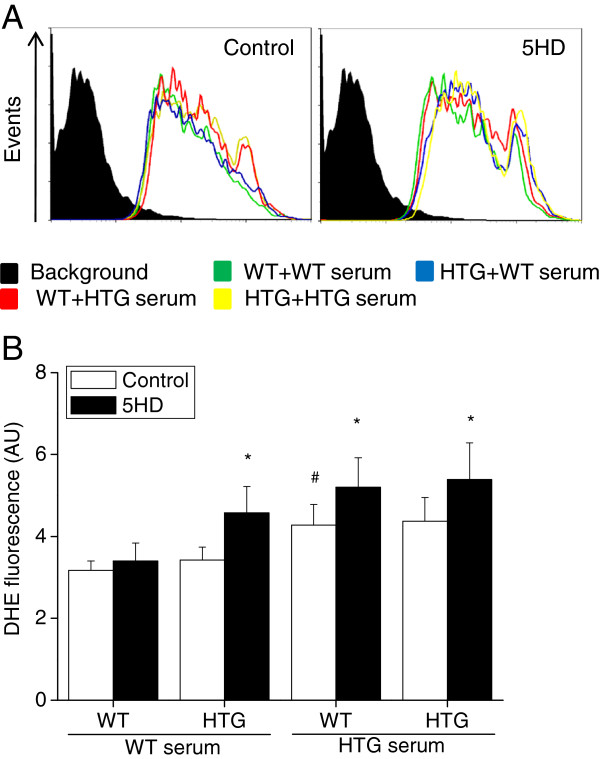
Blood serum from HTG mice induces superoxide generation in spleen mononuclear cells. Representative plots from flow cytometry analyses are shown in A, and means ± SEM are depicted in B. Cells (106 cells.ml-1) were incubated for 4 h in RPMI 1640 medium containing 10% serum obtained from WT (WT Serum) or HTG (HTG Serum) mice. Green line: WT cells in WT serum; blue line: HTG cells in WT serum; red line: WT cells in HTG serum; and yellow line: HTG cells in HTG serum. *P < 0.05 for 5HD vs. respective control condition. The results are expressed as means ± SEM, n = 9. #P < 0.05 vs. control WT cells in WT serum.